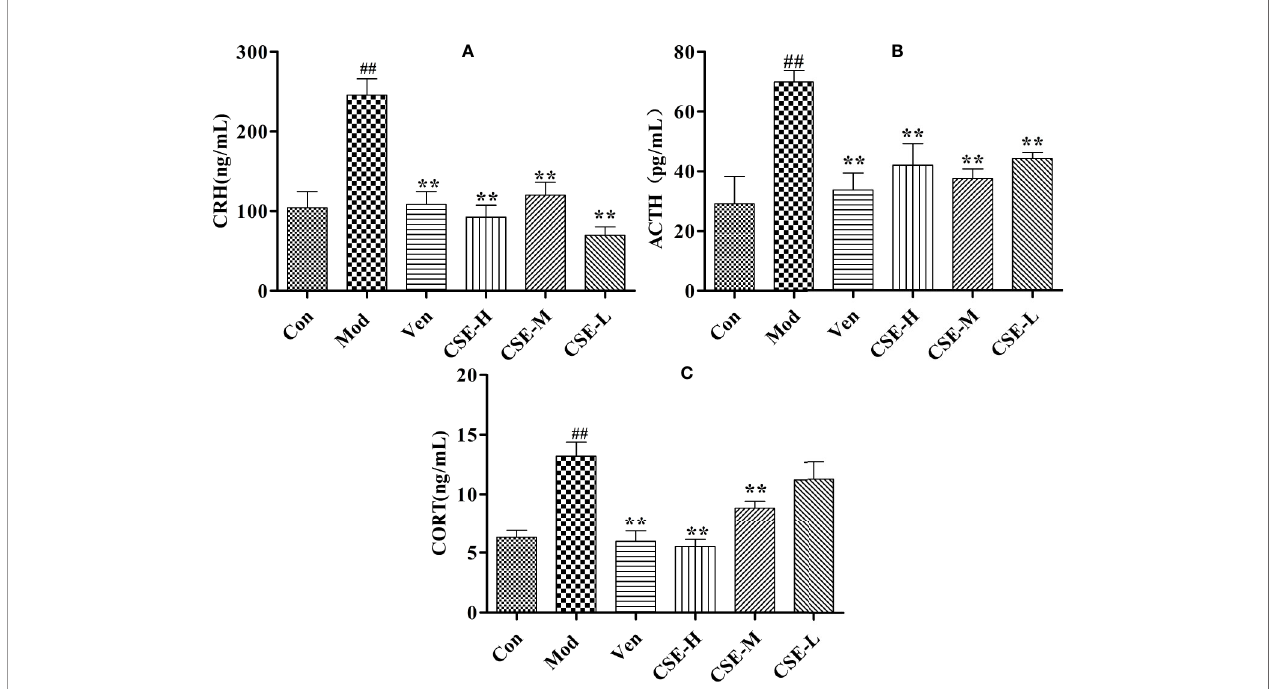
FIGURE 5 | The effects of CSE on HPA axis of CUMS rats. (A) Corticotropin-Releasing Hormone (CRH), (B) Adrenocorticotropic Hormone (ACTH), (C) Corticosterone (CORT). Values given are the mean ± SEM (n = 10). ## P < 0.01 compared with the control group. ** P < 0.01 compared with the model